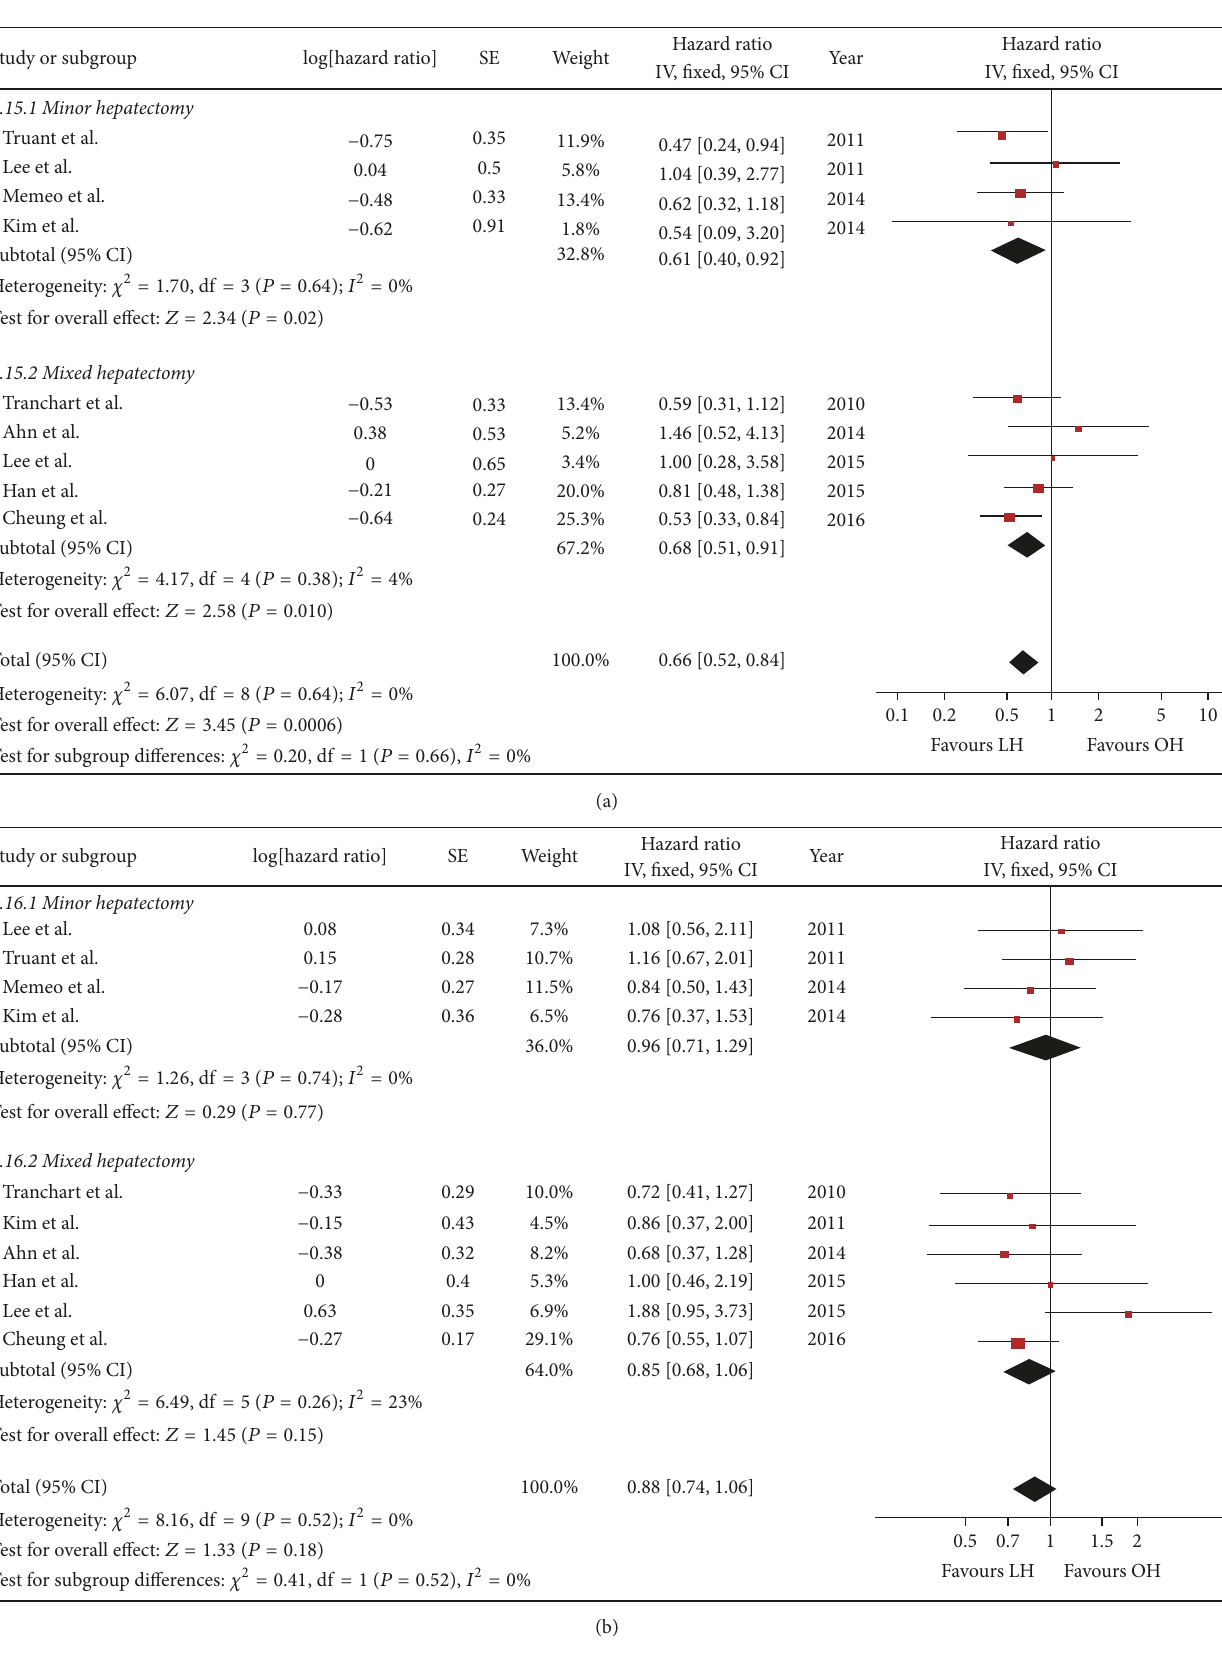
Figure 4: Forest plot of survival rate: (a) 5-year OS, (b) 5-year